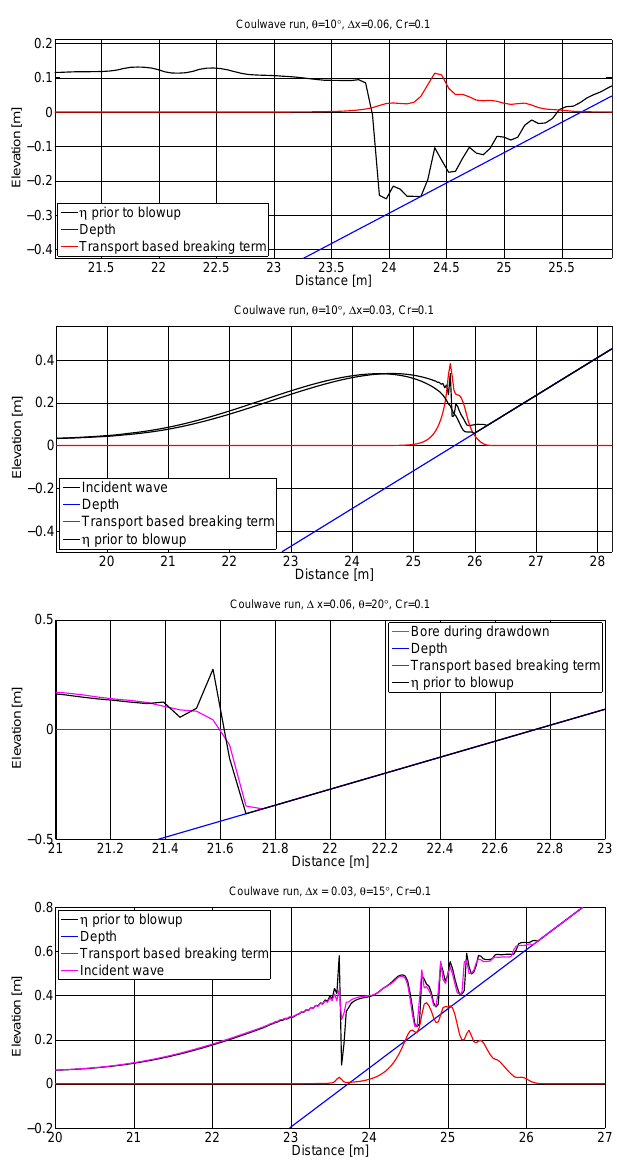
Fig. 8. Model instabilities during run-up using COULWAVE with model 1a. The Courant number is Cr = 0 . 1 and A/d = 0 . 3. Grid res- olutions 1x are relative to the depth d . The invoked breaking term is depicted in red, the bathymetry in blue, and the surface elevation at the time step before blowup in